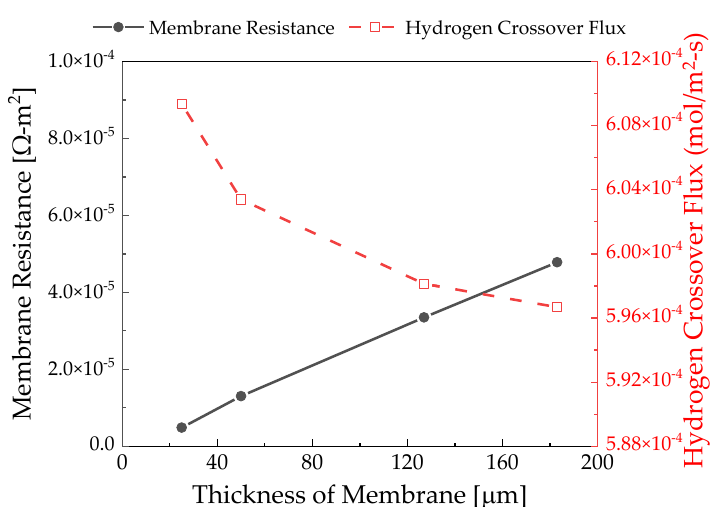
Figure 10. Polymer electrolyte membrane resistance and hydrogen crossover rate according to the thickness measured at 0.18 V.